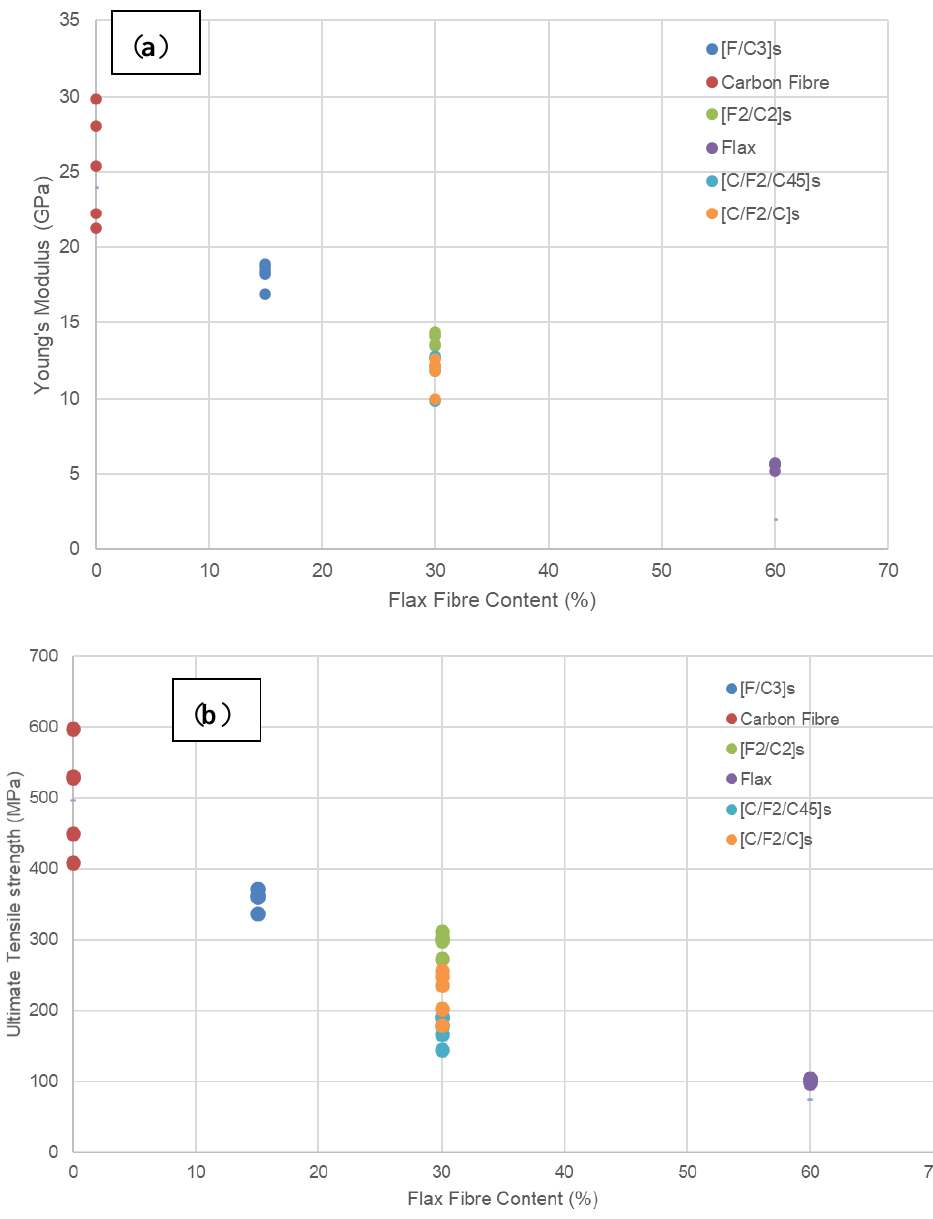
Figure 4. The Young’s modulus ( a ) and the ultimate tensile strength ( b ) for investigated composite materials .